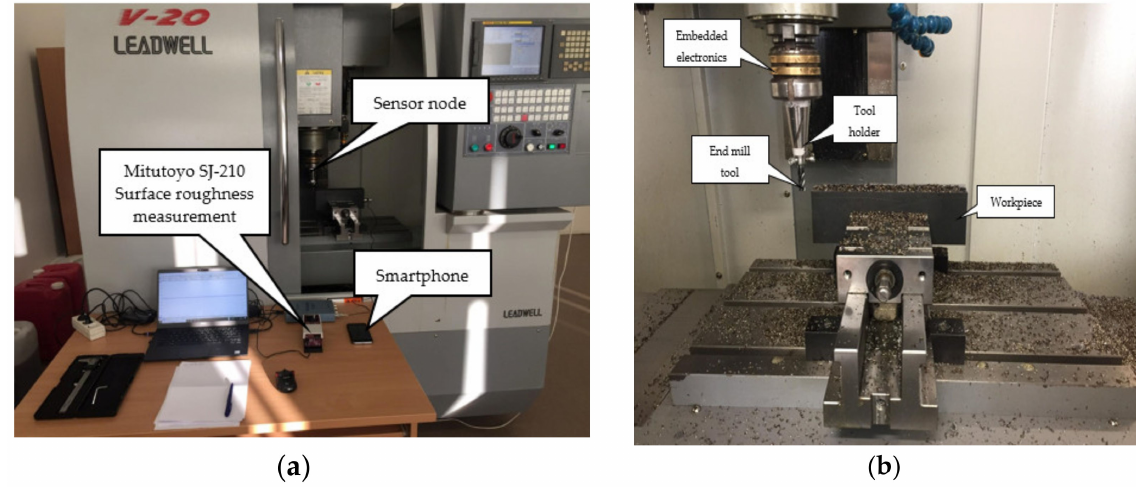
Figure 14. Wireless sensor node used for tool condition monitoring assembled inside Leadwell V-20 CNC milling center (Leadwell CNC Machines MFG., Corp., Taiwan), ( a )—outside CNC view, ( b )—inside CNC view.